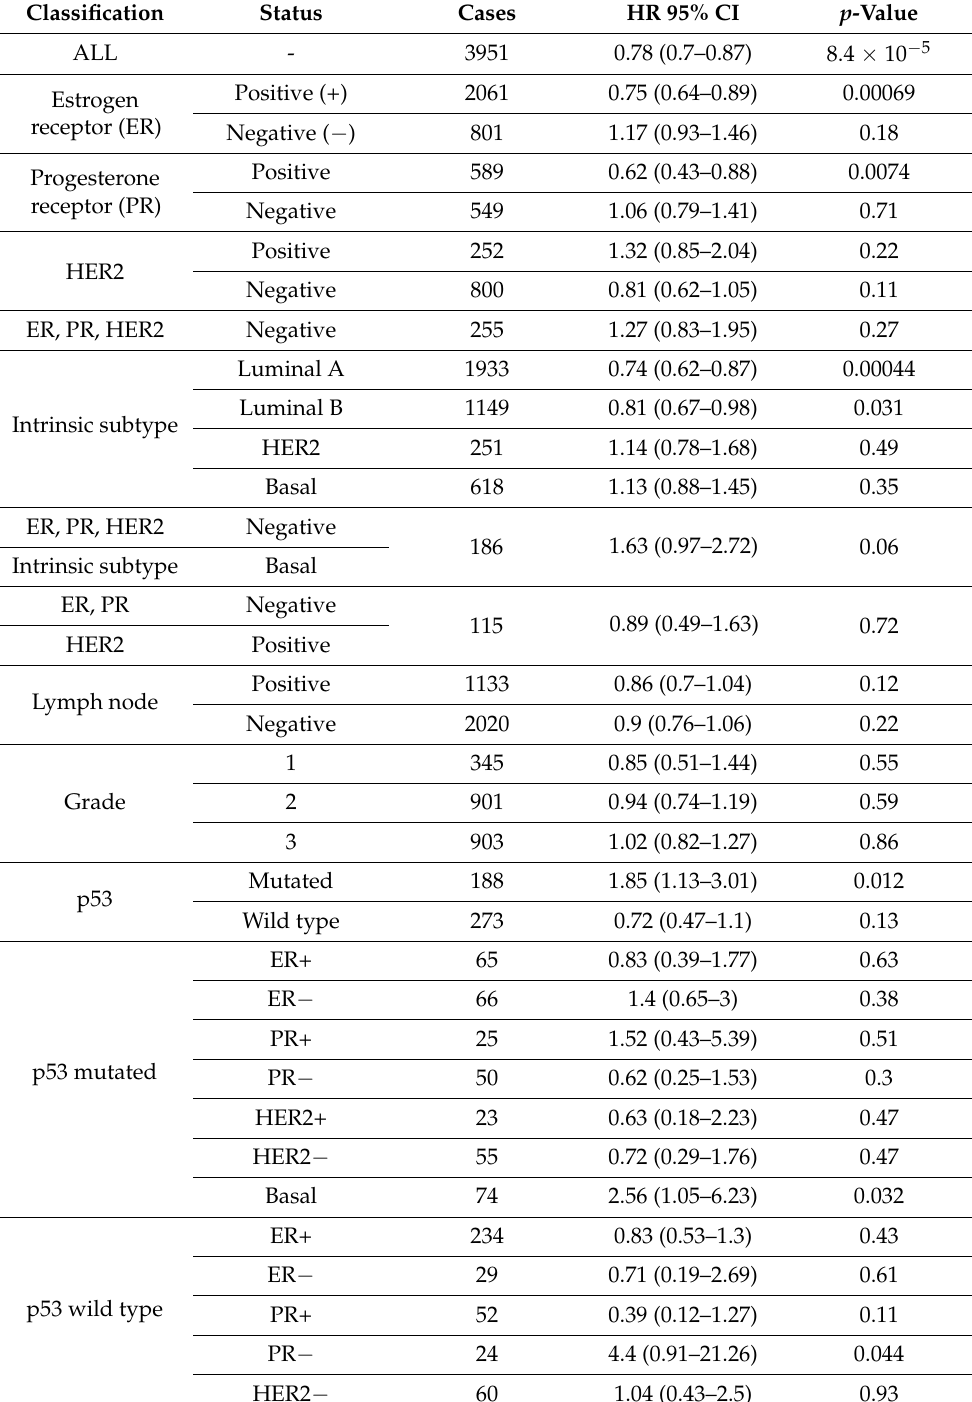
Table 1. Prognostic value of coagulation factor III/TF expression in breast cancer patients stratified according to different clinicopathological